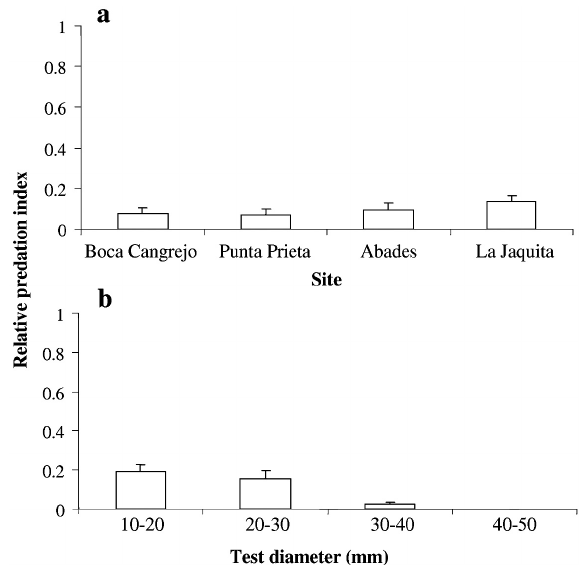
F IG . 6. – Mean survival rates ± SE of Diadema aff. antillarum obtained within (a) sites and (b) sea urchin size classes with predation